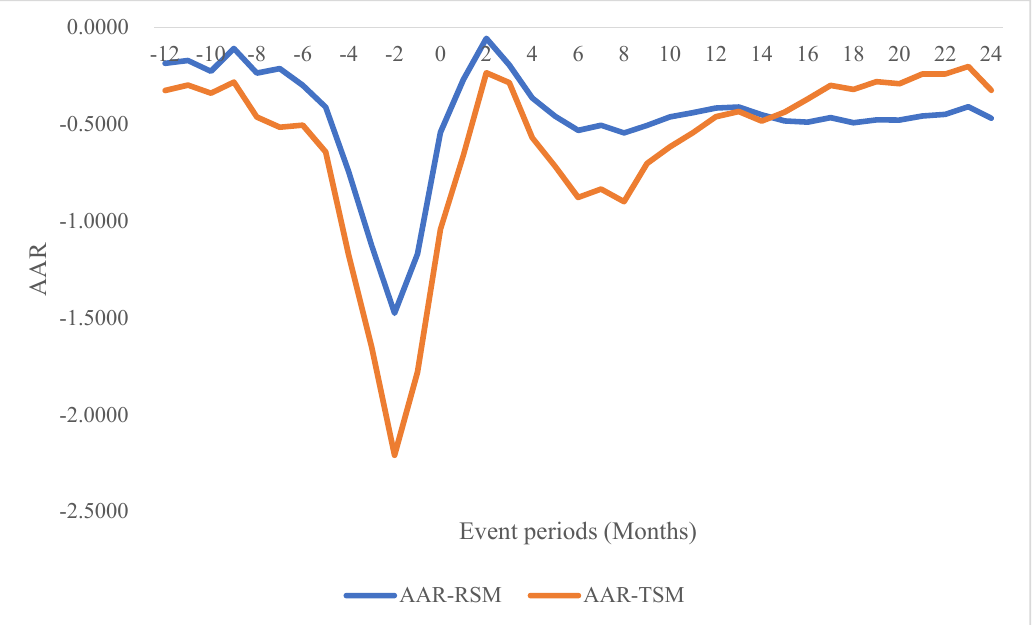
Figure 2. Average abnormal return of RSM and TSM. Note: the event periods are from − 12 months to 24 months.